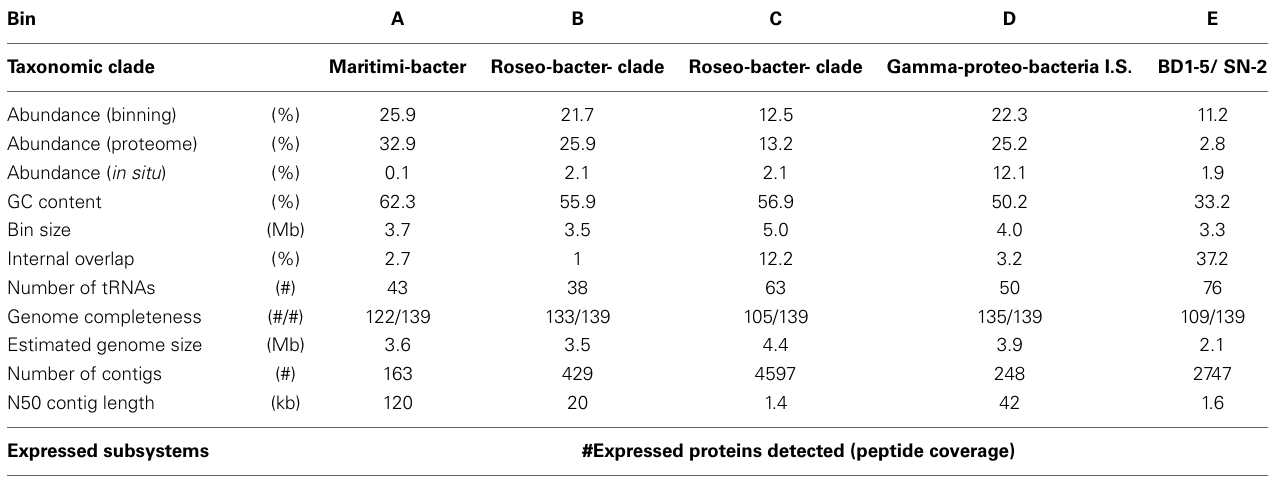
Table 3 | Characteristics and metabolism of the binnable populations at t = 23 days (n.d. = not detected).